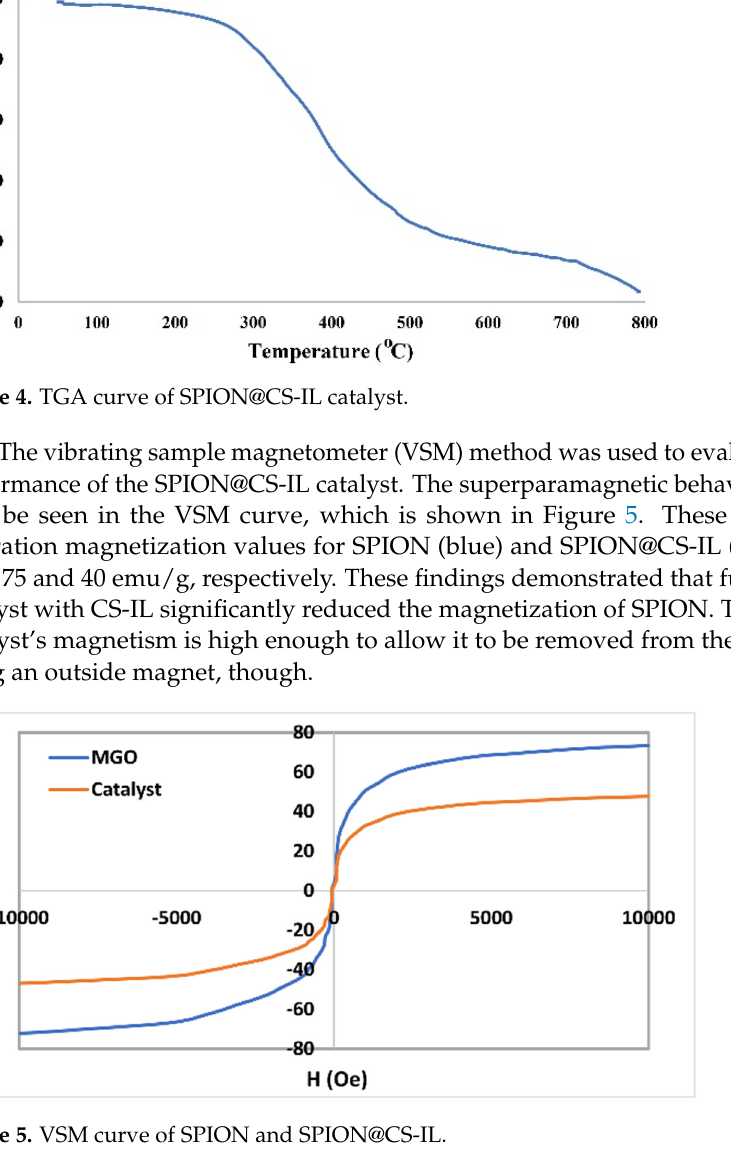
Table 1. The optimization of the reaction conditions for the synthesis of 4g (R=4 − NO 2 ).